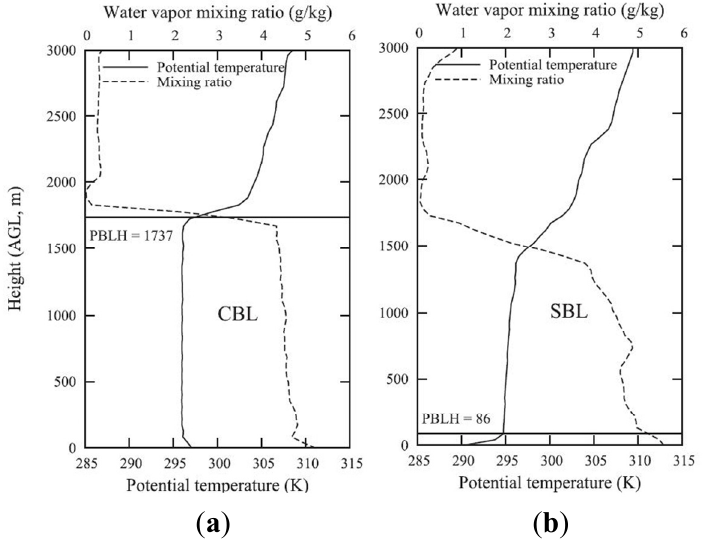
Figure 12. Case of water vapor mixing ratio and potential temperature profile under convective ( a ) and stable air conditions ( b ). The horizontal line depicts the position of the determined planetary boundary layer height (PBLH)